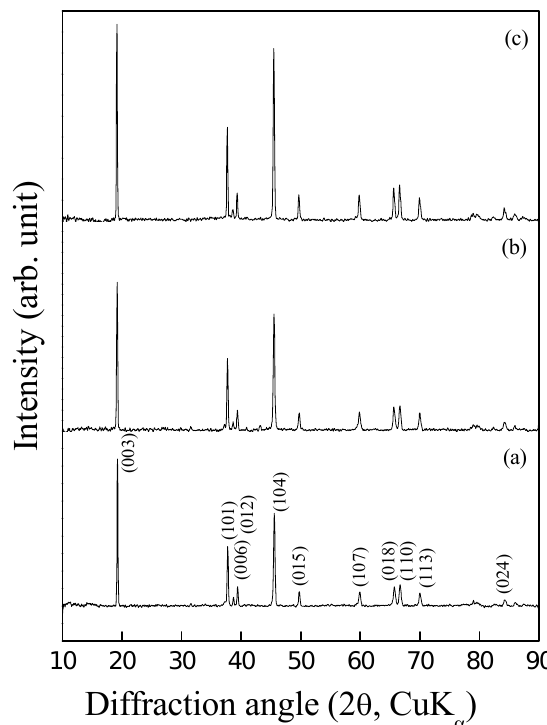
Figure 4. Powder X-ray diffraction patterns for (a) pristine LiCoO 2, (b) LiCo 0.95 Mg 0.05 O 2 and (c) LiCo Al O 0.95 0.05 2